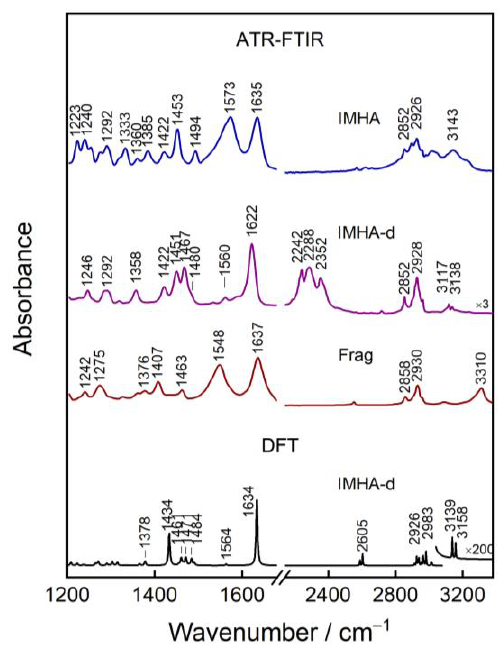
Figure 3. ATR-FTIR and DFT spectra of bulk IMHA and molecular fragment. IMHA-d refers to S–D- and N–D-substituted IMHA molecules. Table 1. ATR-FTIR, SEIRAS, and DFT vibrational modes and assignments of IMHA and deuterium- substituted IMHA (IMHA-d). DFT